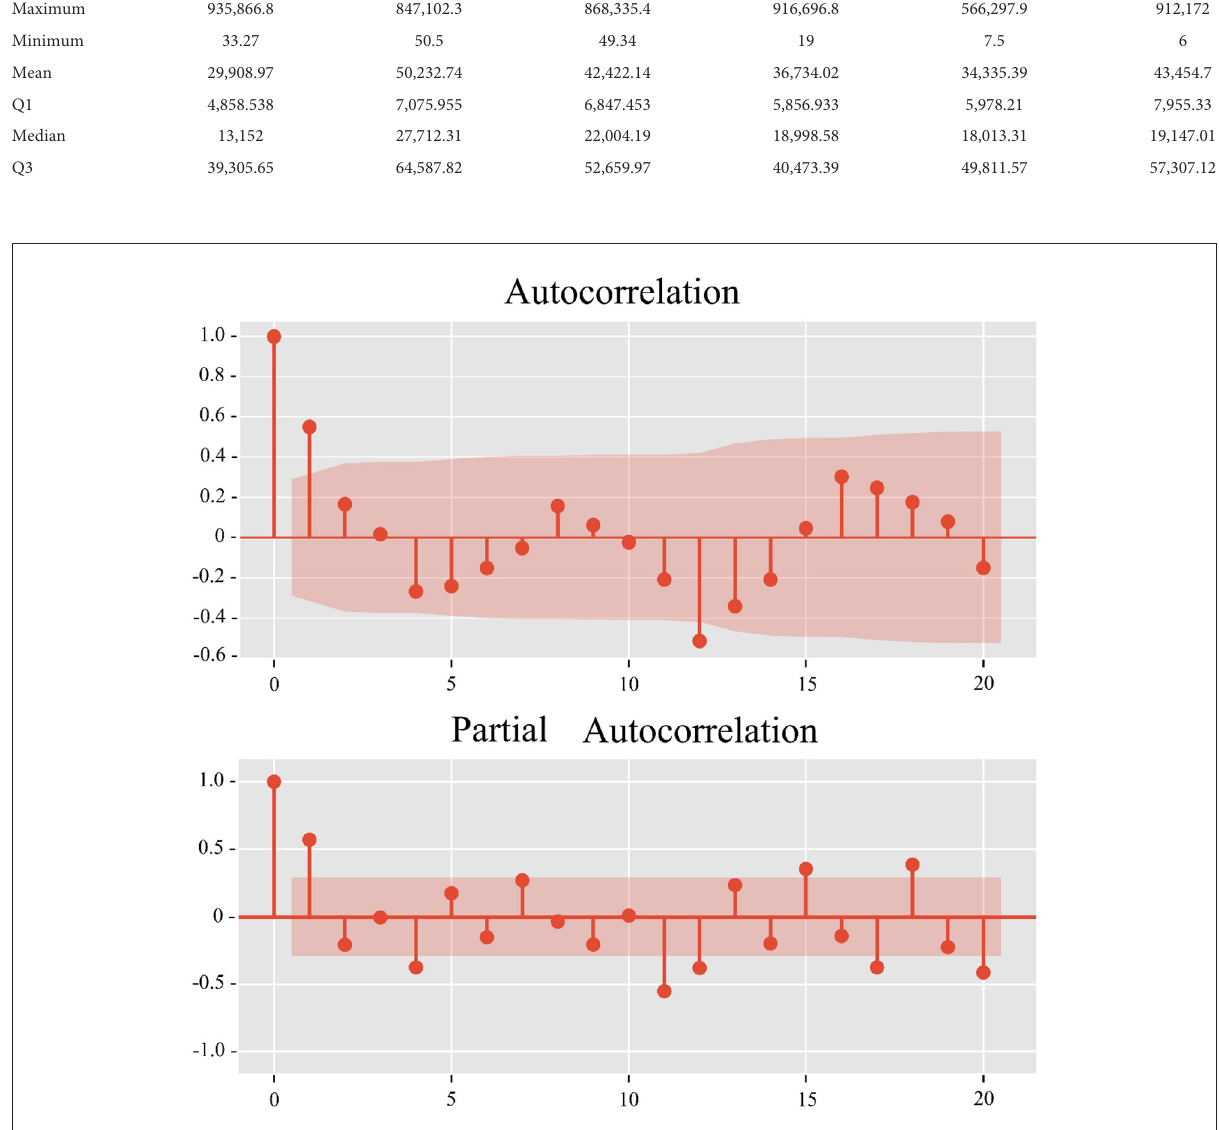
FIGURE4 ACF and PACF images of the SARIMA (1,1,0), (2,1,3) 12 model.